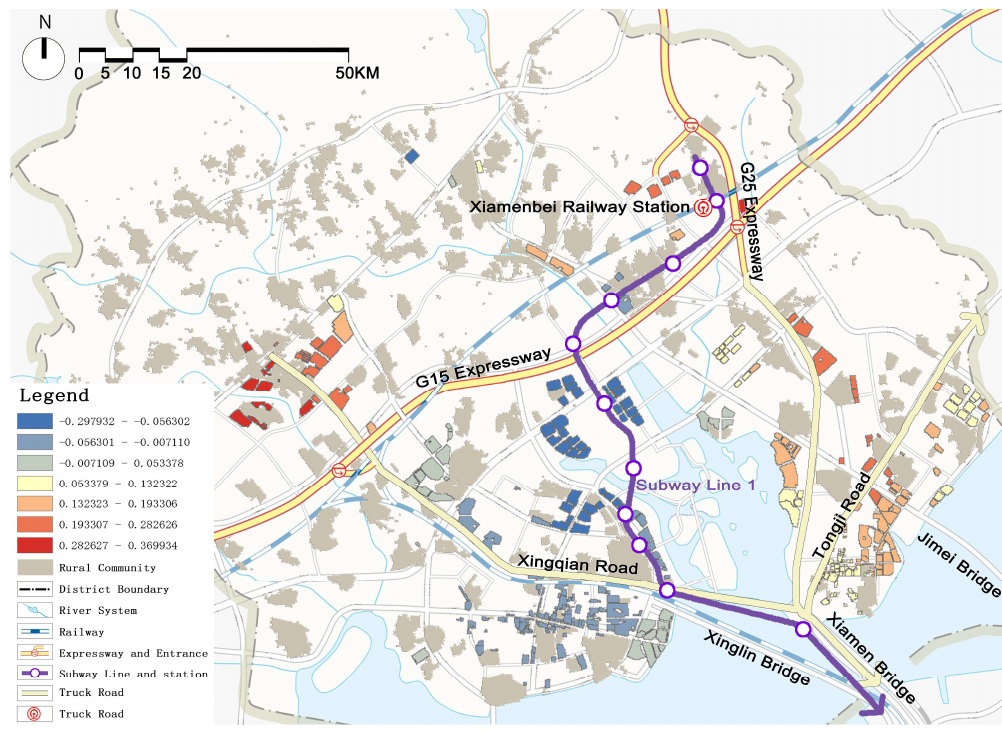
Figure 4. Spatial pa(cid:308)ern of job accessibility coefficient.